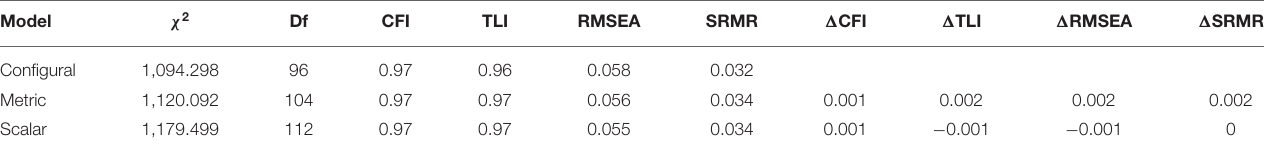
TABLE 6 | Fit indicators to assess the invariance of gender on the EduFlow-2